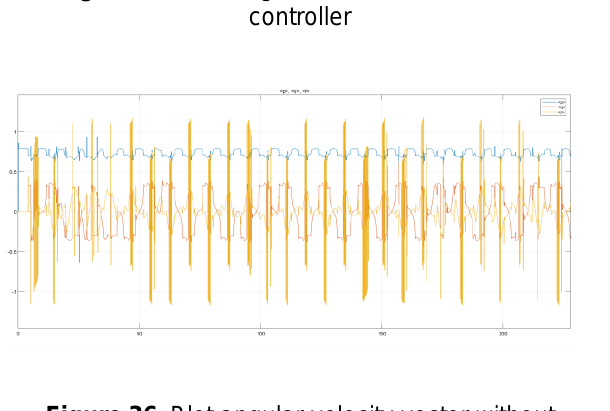
Figure 36. Plot angular velocity vector without attitude